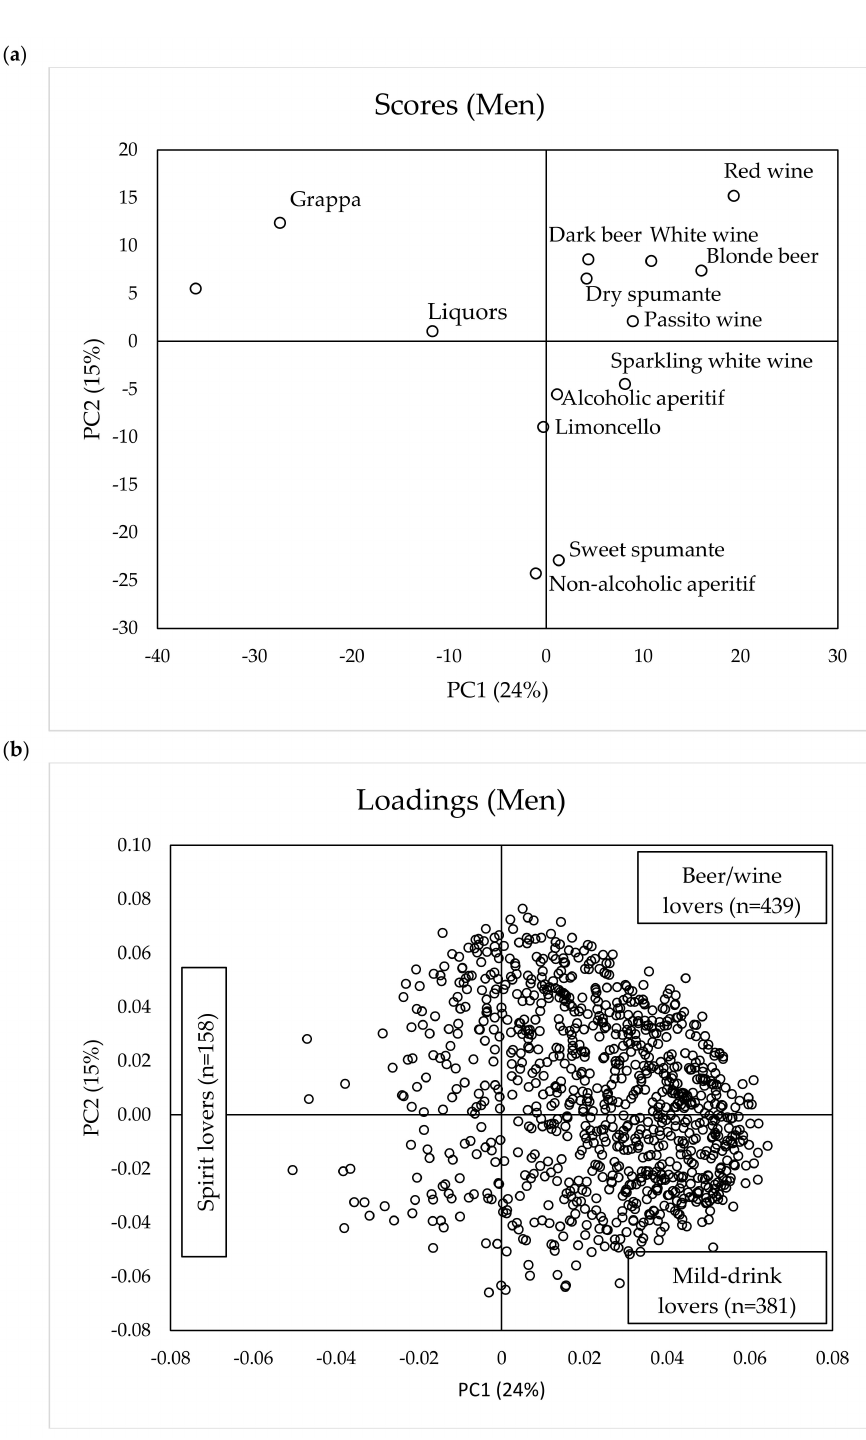
Figure 2. Scores ( a ) and loadings ( b ) obtained from PCA performed on liking (9-point hedonic scale) of di ff erent alcoholic beverages by men consumers ( n =